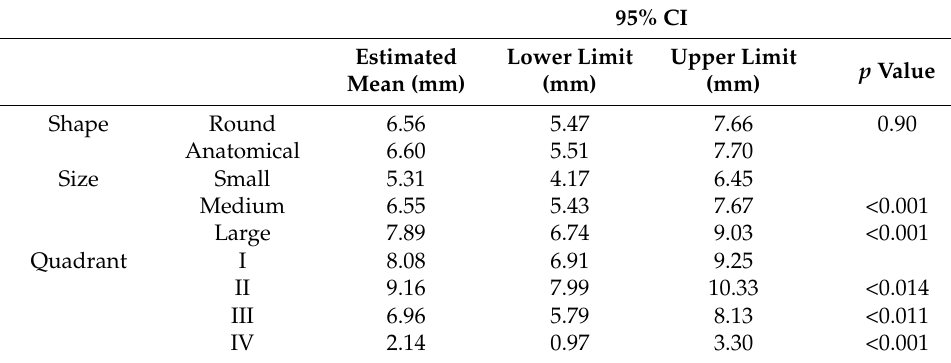
Table 3. Impact of main effects on topographic